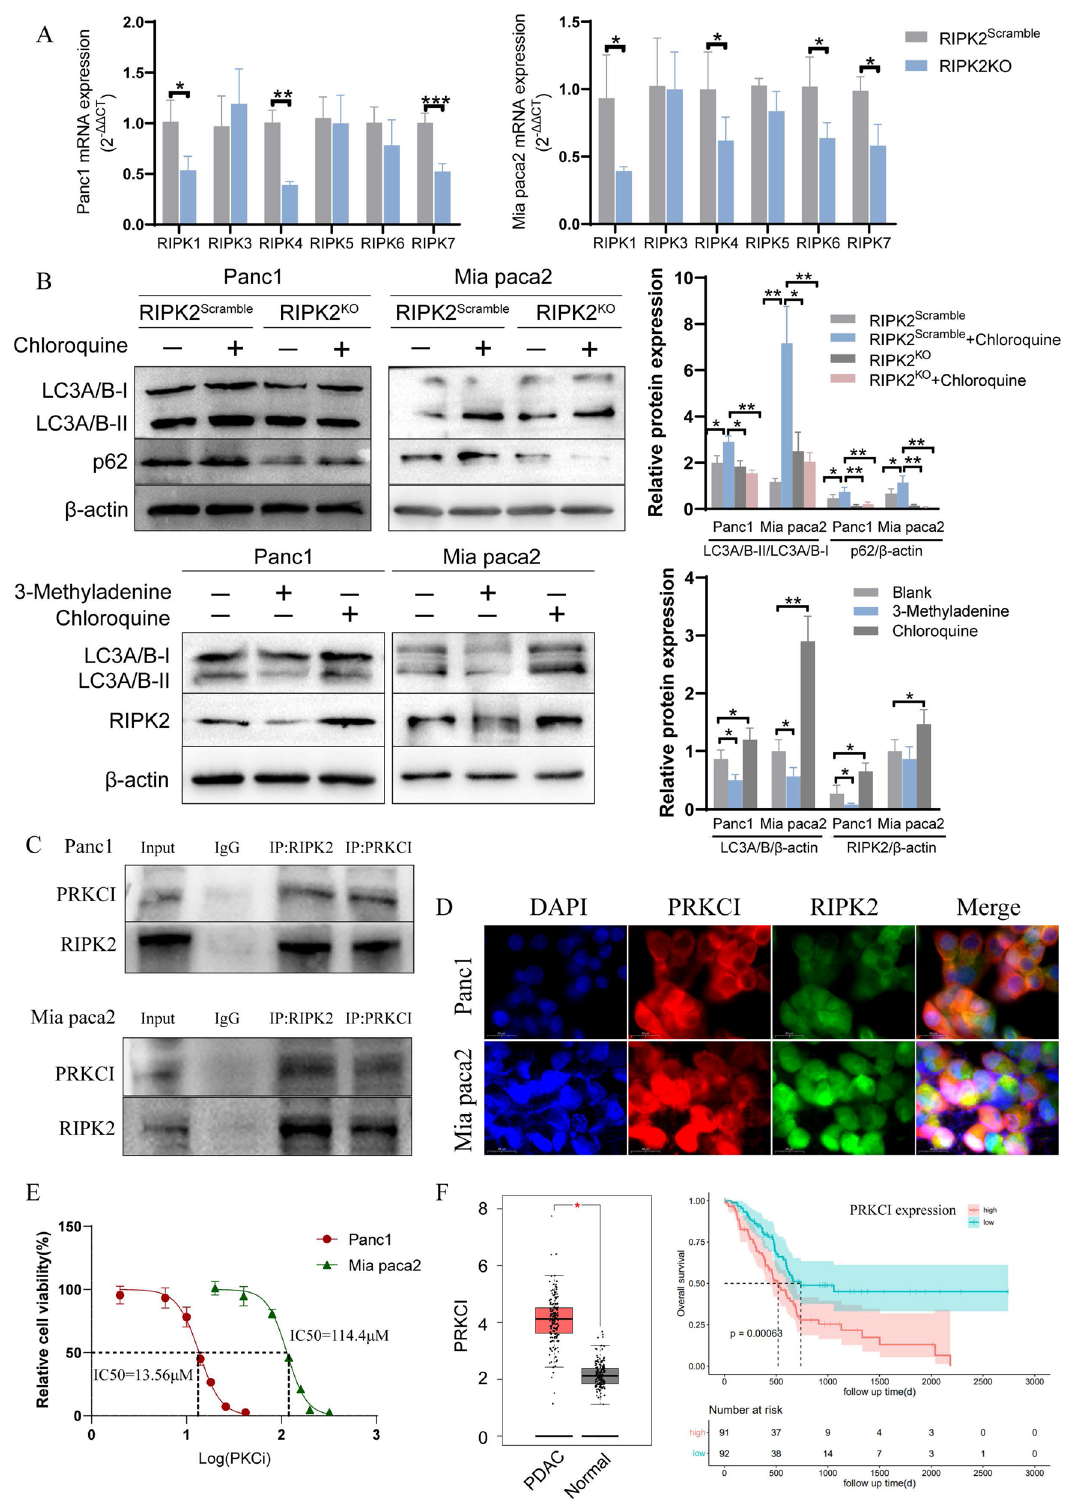
Fig. 7 RIPK2 can interact with RIPKs family members and PRKCI, and participate in autophagy. A mRNA expression of RIPKs family members. B The effects of RIPK2 expression on autophagy, and autophagy on the expression of RIPK2. C Coimmunoprecipitation of RIPK2 and PRKCI. D Colocalization assay of RIPK2 and PRKCI by immunofluorescence. E PKC iota inhibition (PKCi) can decrease pancreatic cell viability. F Expression and survival analyses of PRKCI in pancreatic cancer through GEPIA database. * p < 0.05, ** p < 0.01, *** p <